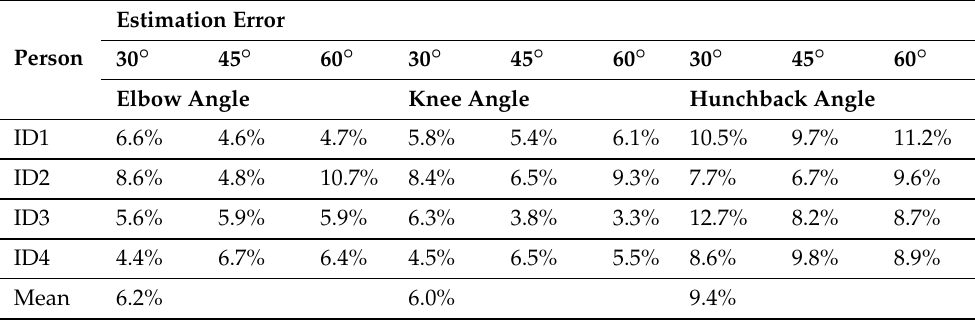
Table 1. Static measurement error of HPI with 4 persons under 3 different